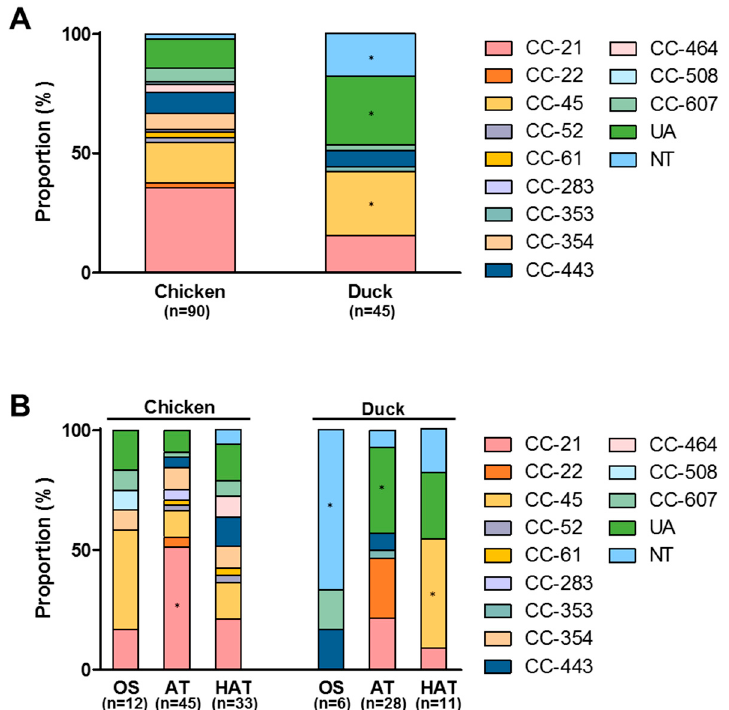
Figure 1. Multilocus sequence typing (MLST) sequence types of C. jejuni strains from retail raw chicken and duck meat ( A ), and the distribution of MLST clonal complexes (CCs) in C. jejuni strains with different aerotolerance levels from retail raw chicken and duck meat ( B ) in Korea. UA: unassigned to any CC defined, NT: not typable. *: p < 0.05.